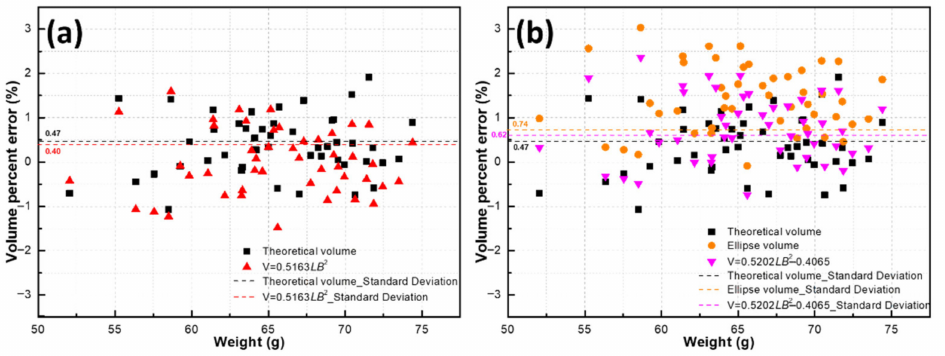
Figure 4. The volume percentage error corresponds to the actual weight of the egg. ( a ) theoretical volume Equations (18) and (19); ( b ) theoretical volume Equation (18), elliptical volume equation, Equation